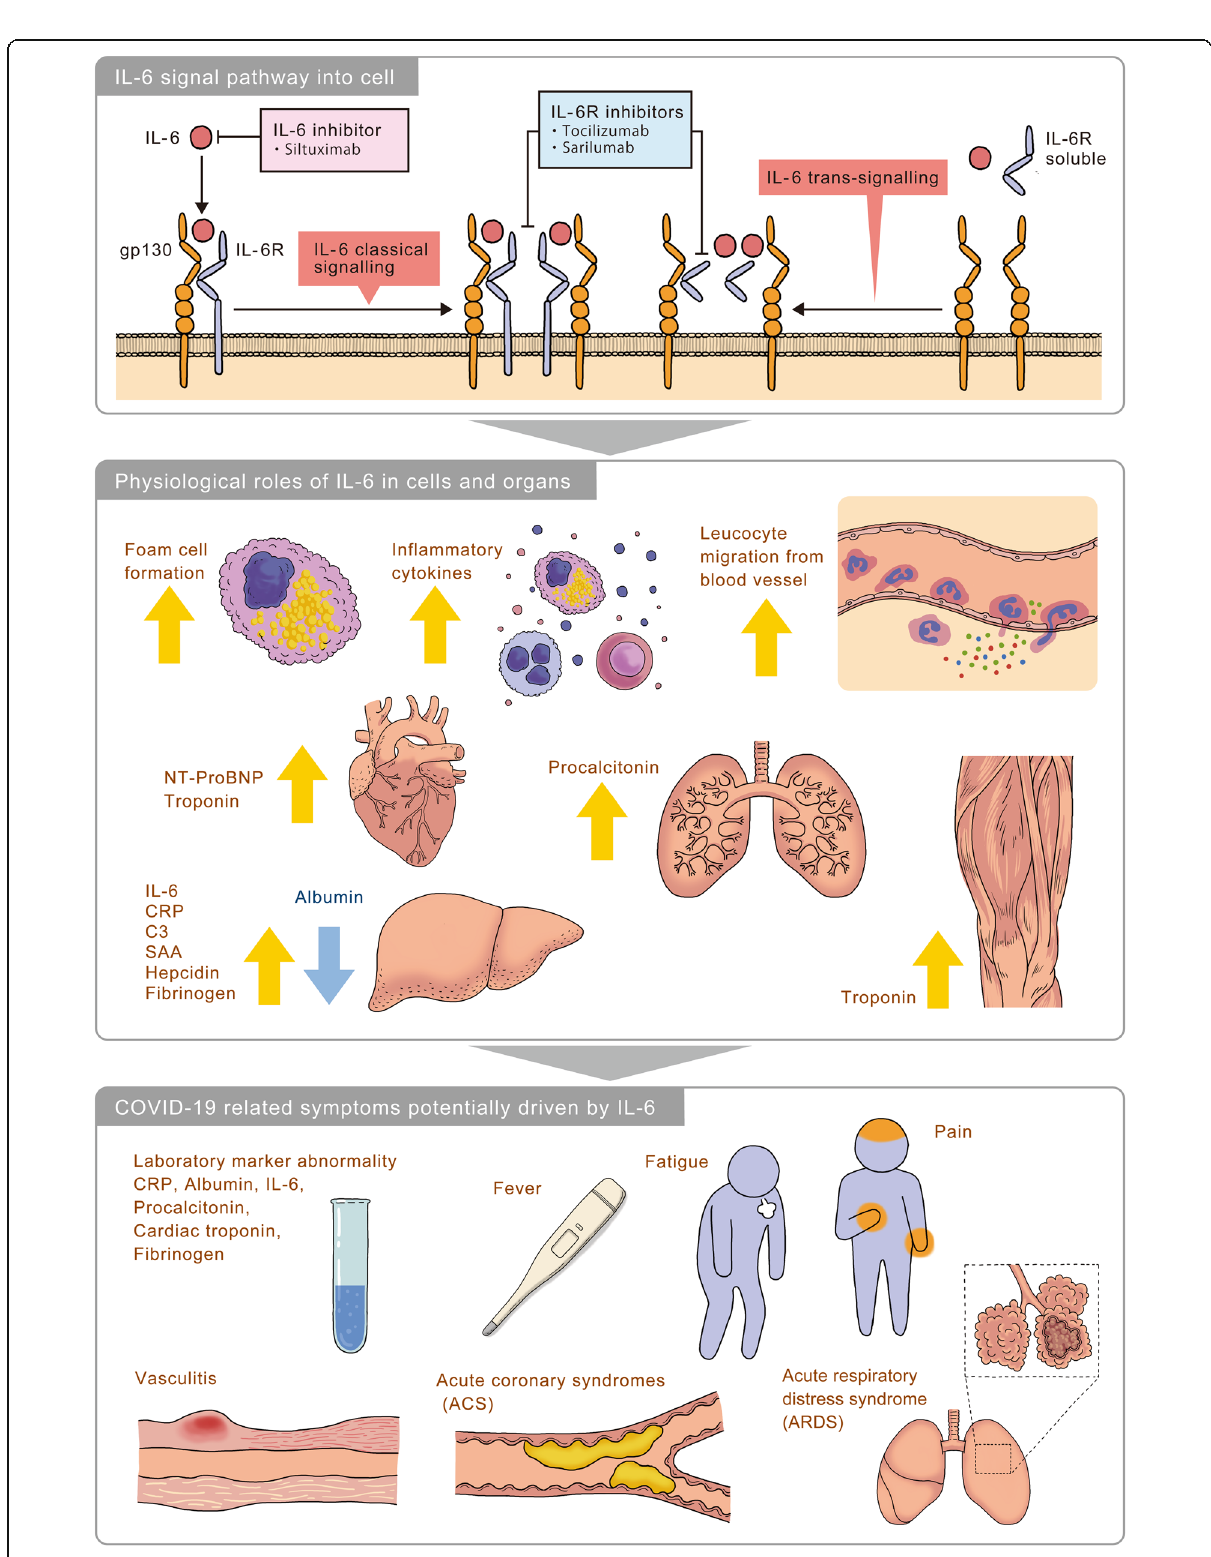
Fig. 1 (See legend on next